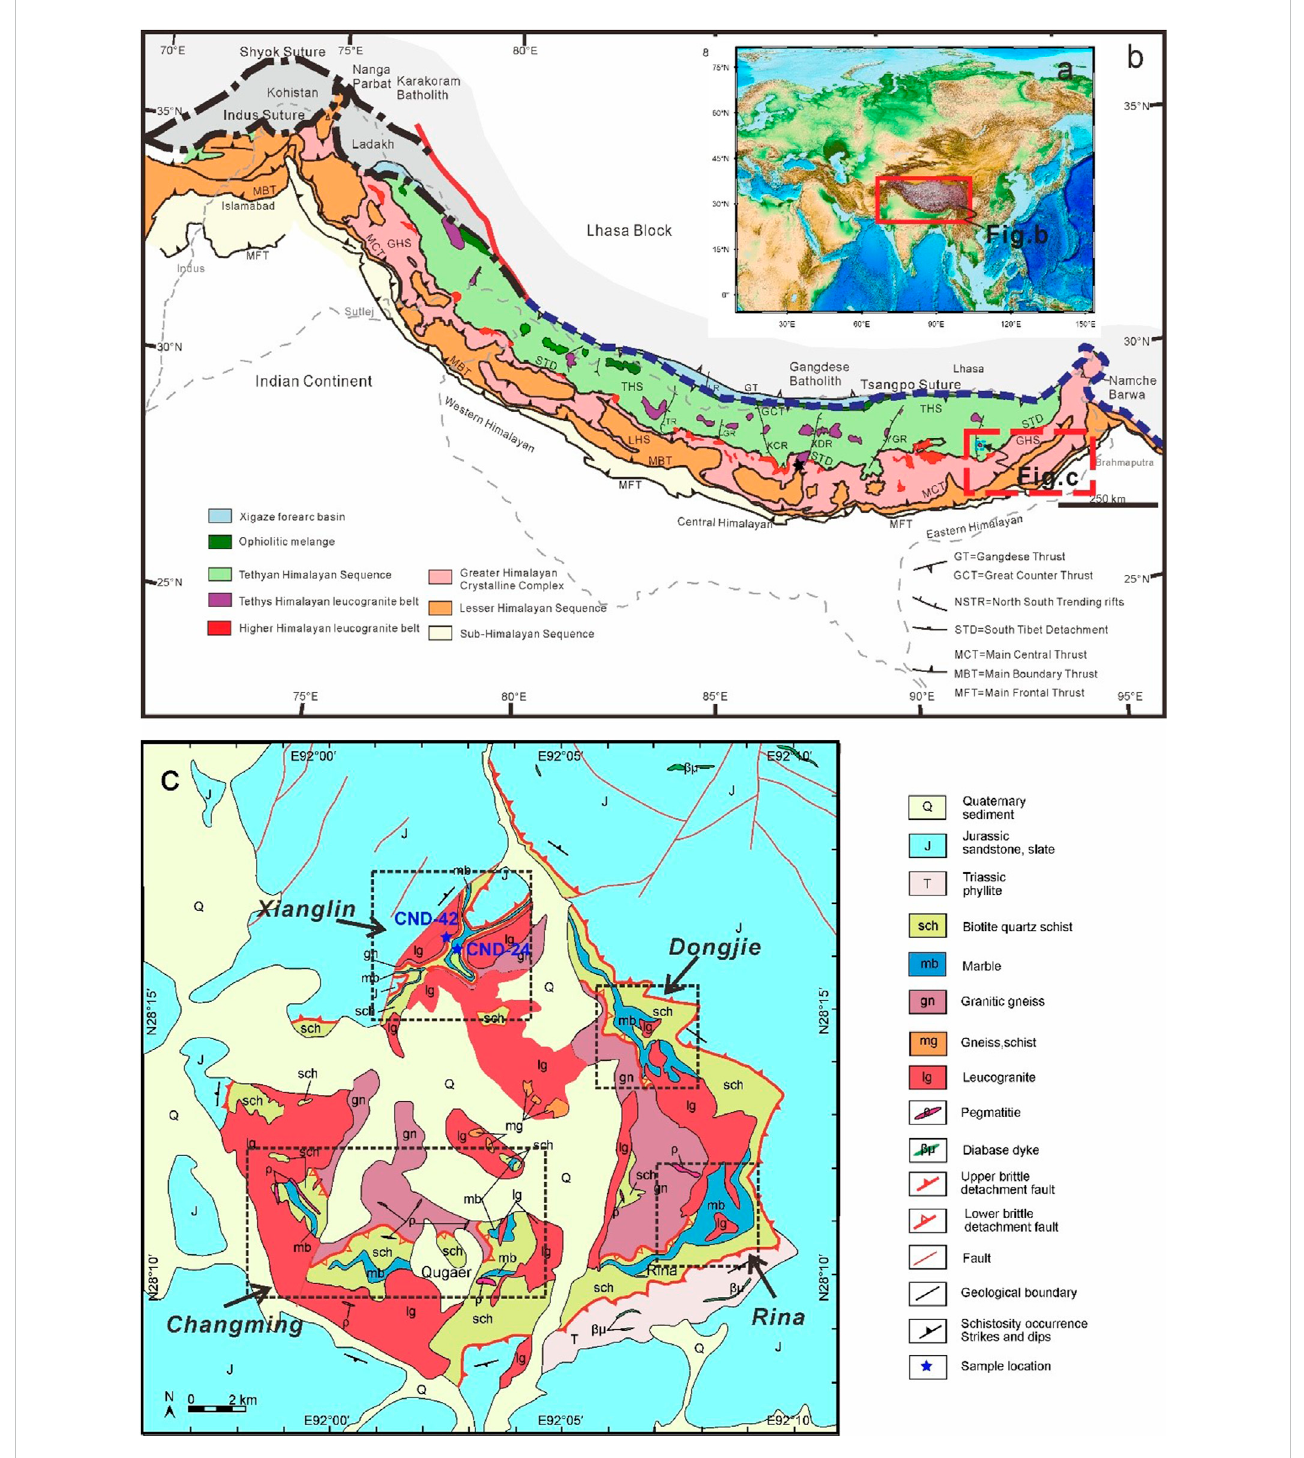
FIGURE 1 Geological map of the Himalayan orogenic belt and Cuonadong dome. (A) Map of the Tibetan Plateau. Background relief maps were downloaded from NOAA (https://www.ngdc.noaa.gov/). (B) Geological map of the Himalayan orogenic belt (Burg and Bouilhol, 2019; Cao et al., 2020). (C) Geological map of the Cuonadong dome and the sample location after Cao et al.